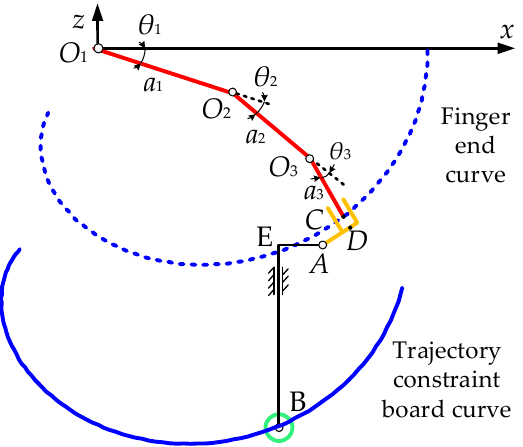
Figure 20. Motion mechanism diagram of four finger flexion/extension motion assembly.